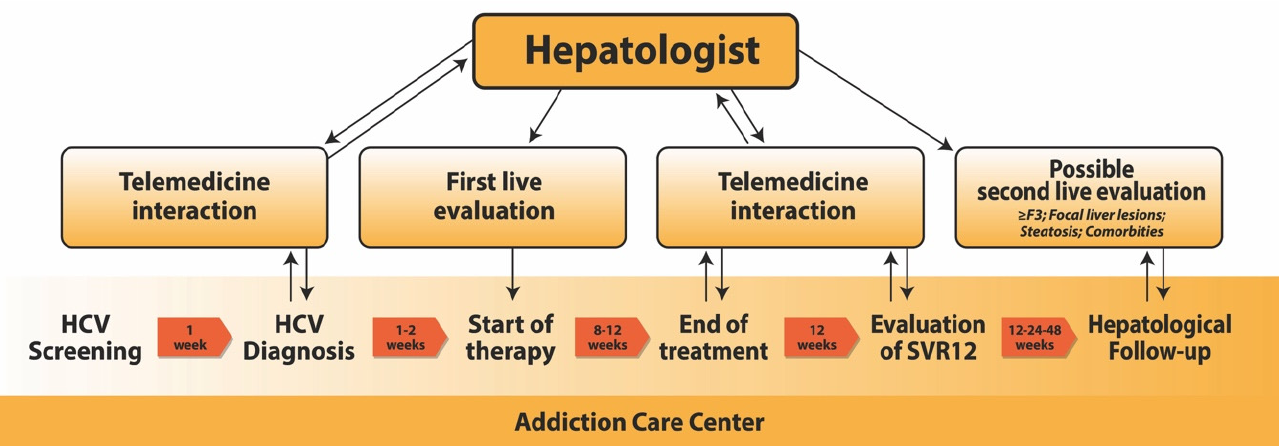
Figure 1. Graphic description of our “patient-centered approach” to HCV treatment in